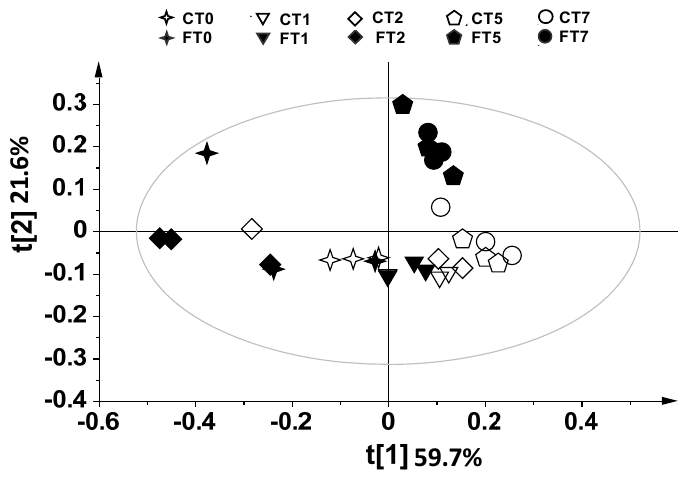
Figure 1. PCA t[1]/t[2] score plot of SPME-GC/MS data. FT0, FT1, FT2, FT5 and FT7: F. poae -infected samples, analyzed at Day 0, 1, 2, 5 and 7, respectively; CT0, CT1, CT2, CT5 and CT7: controls analyzed at Day 0, 1, 2, 5 and 7, respectively. Filled symbols: F. poae -infected samples (FT); empty symbols: controls (CT).